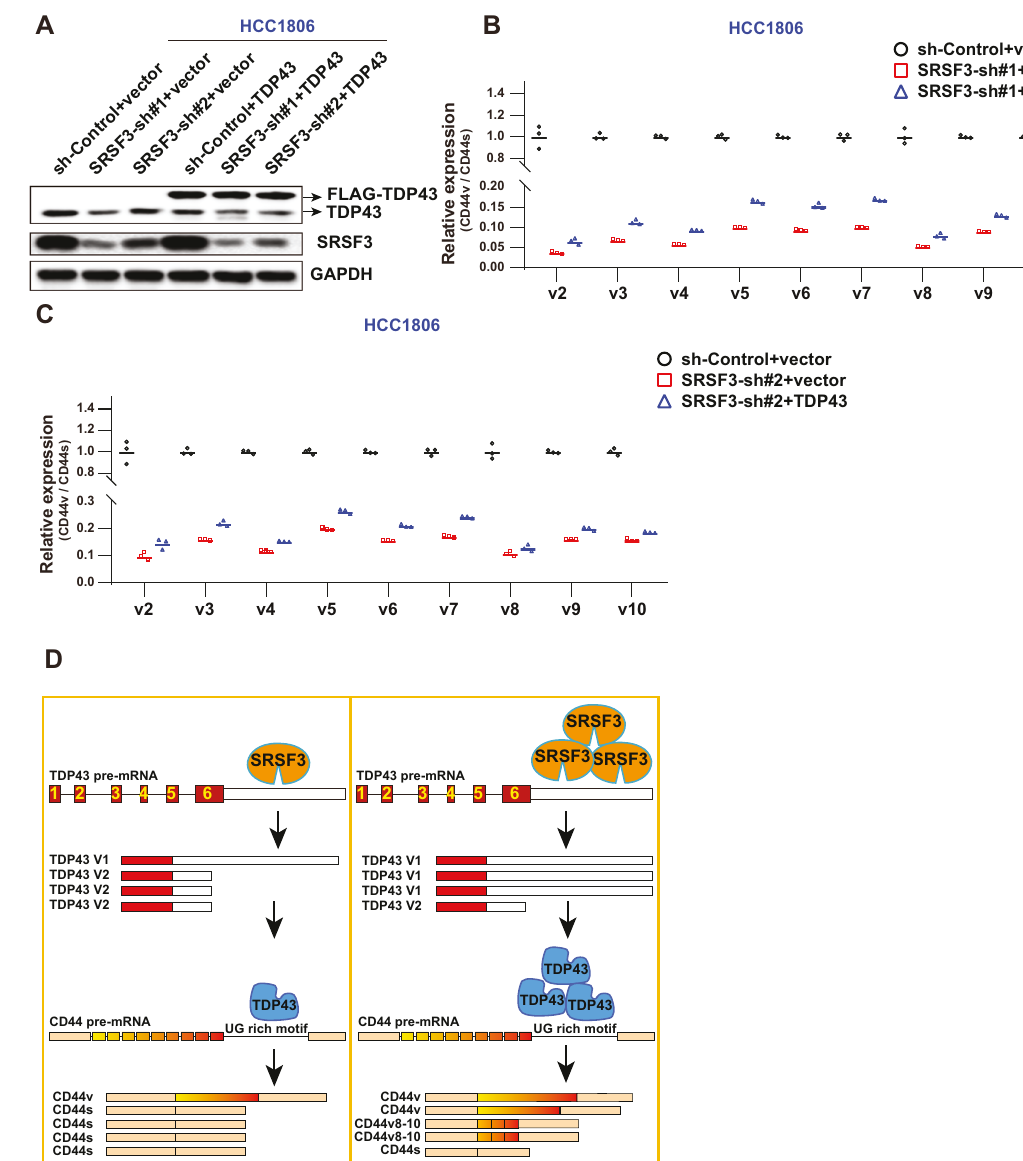
Fig. 6 SRSF3 enhances CD44v inclusion through regulation of TDP43. A Western blot analysis of SRSF3 KD and TDP43 OE ef fi ciency. B , C qPCR analysis of CD44v/s following SRSF3 KD, TDP43 OE, or SRSF3 KD/TDP43 OE in HCC1806 cells. D Graphical abstract of roles of SRSF3- TDP43 axis in regulating CD44 splicing. High SRSF3 expression increases TDP43 abundance and CD44s expression. After SRSF3 KD, TDP43 levels decrease, reducing TDP43-binding to CD44 pre-mRNA, leading to CD44v to CD44s splicing transformation. Data are means ±